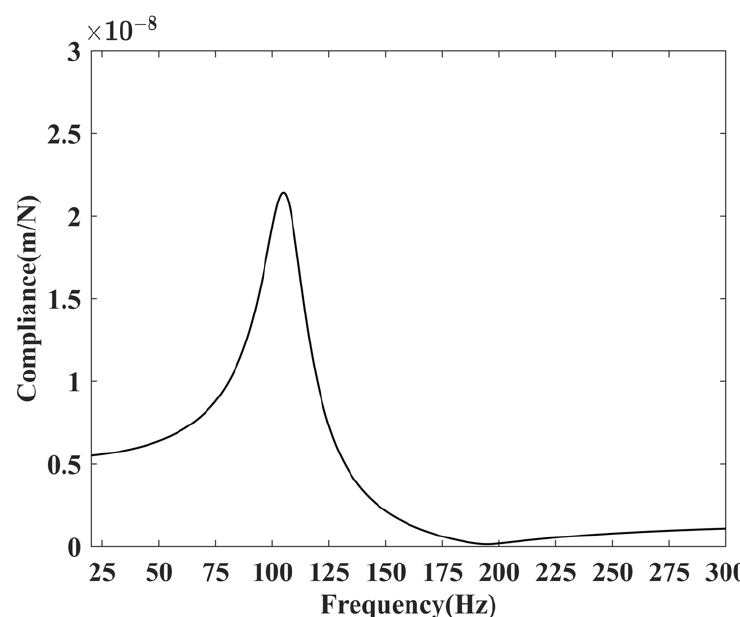
Figure 11. Dynamic flexibility of the thrust bearing.